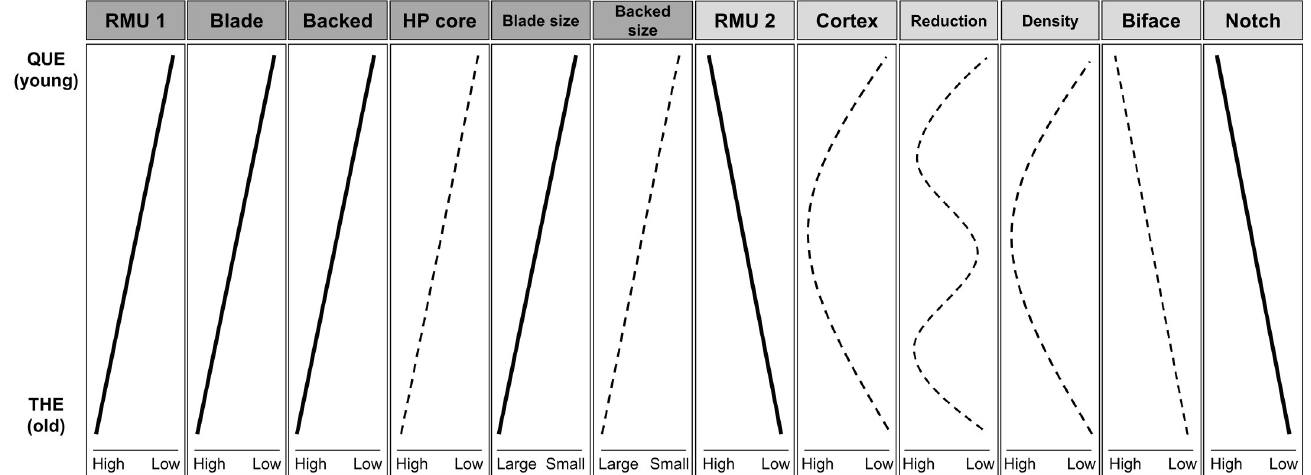
Fig 11. Schematic overview of diachronic trends in the HP sequence at Sibudu. Trajectories of the lines are based on descriptive information (increase, decrease, one peak, multimodal/curving), analytical results are reflected in the type of lines (dashed lines = not significant; bold lines = significant). Blade size = Blade length and width; Backed size = Backed piece length and width; RMU 1 = Dolerite; RMU 2 = Sandstone; Reduction = Assemblage reduction intensity; Density = Lithic and faunal find density.